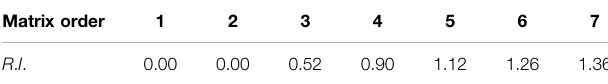
TABLE 1 | Scaling method for element a ij of judgment matrix. TABLE 2 | Average random consistency index